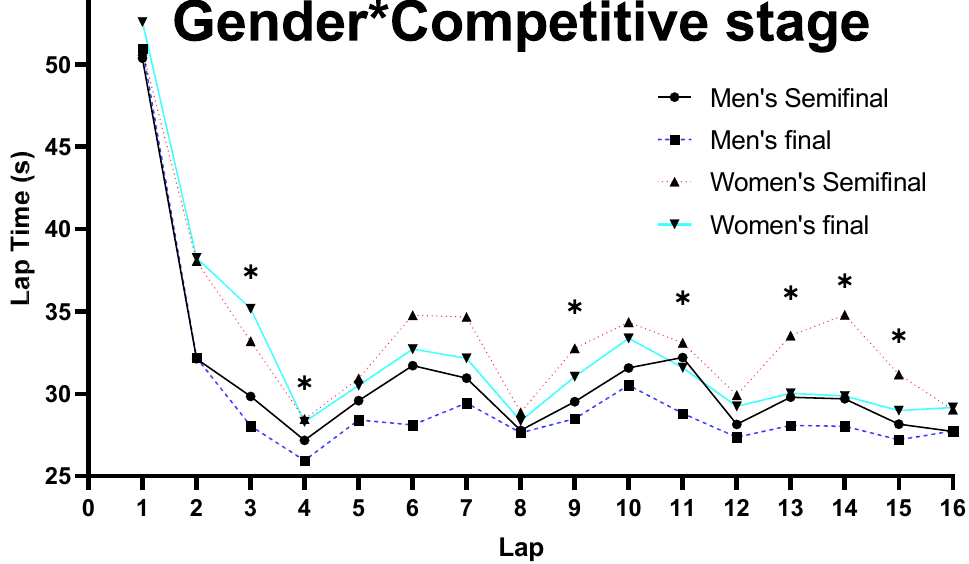
Figure 5. Comparison of lap time spent between G and CS. Note: * marked values were significant when p ≤